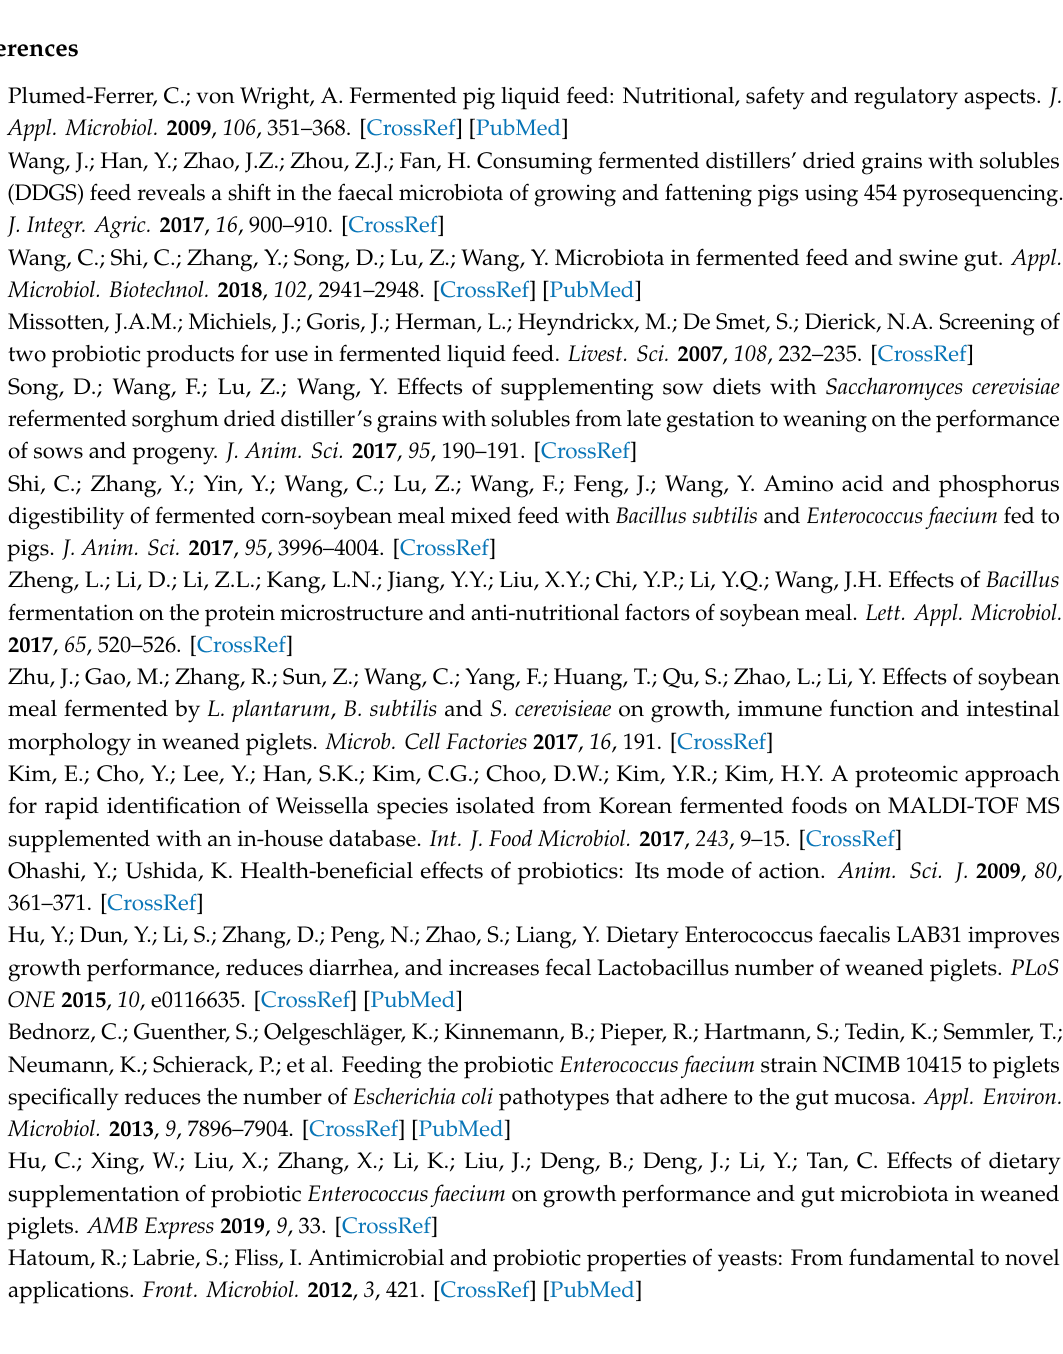
s1: Figure S1: Rarefaction curves based on OTUs in fermented feed samples. Table S1: The procedure of gradient